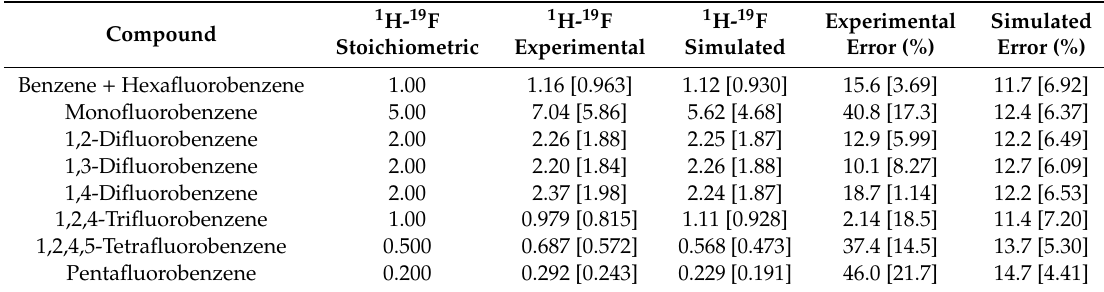
Table 4. Quantitation results for fluorobenzene compounds. Values within brackets ([ · ]) indicate values obtained after scaling the area by the receptivity factor Ξ (Equation (5).